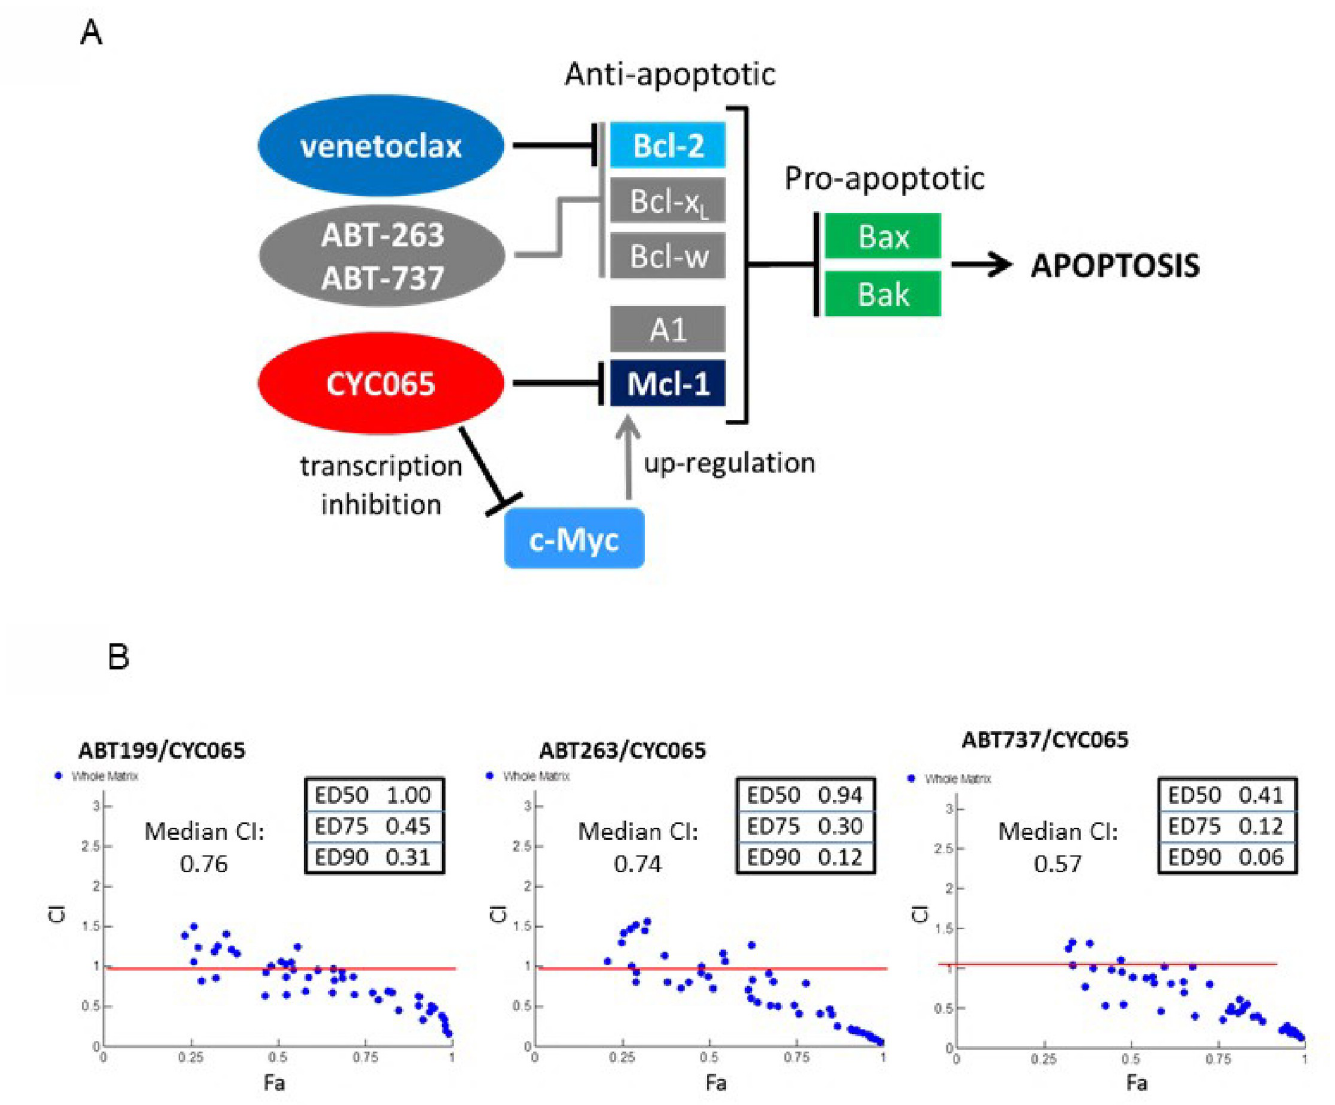
Fig 6. Dual targeting of MCL1 and BCL2 is highly synergistic at inducing cell death. A. Schematic diagram of BCL2 family members, interaction and inhibitors. Venetoclax (ABT-199) is a selective BCL2 inhibitor, whereas ABT-263 and ABT-737 inhibit BCL2, BCL2L1 and BCL2L2. Bcl-x L = BCL2L1, Bcl-w = BCL2L2, A1 = BCL2A1 / Bfl-1. B. Fadraciclib (CYC065) combines synergistically with inhibitors of the BCL2 family in THP-1 cells. y axis–combination index (CI); x-axis– fraction affected (Fa). CI values were calculated using the method of Chou and Talalay [36]. CI values of 0.9–1.1 indicate an additive drug interaction, CI values of > 1.1 are considered antagonistic and CI values < 0.9 are considered